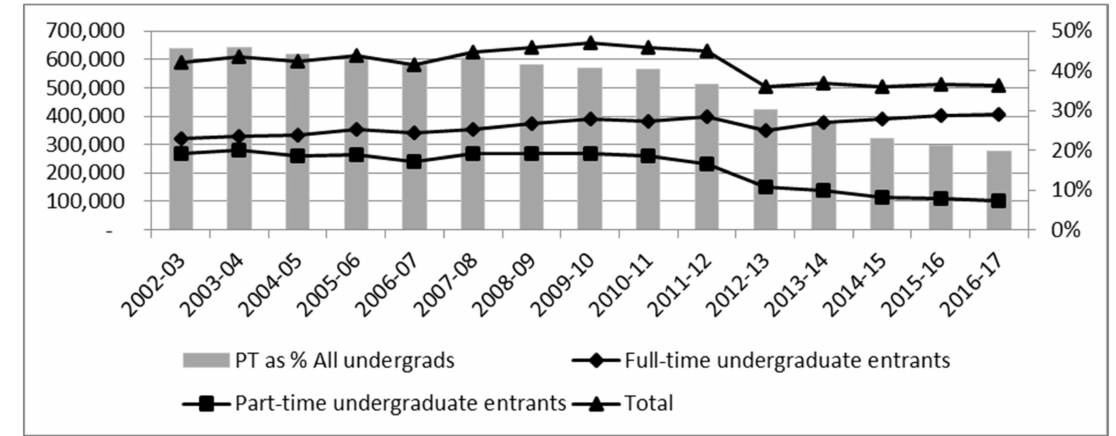
Figure 1. UK and other EU entrants to English HE Institutions and FE Colleges, 2002–2003 to 2016–2017. Source: Derived from HEFCE (2015,